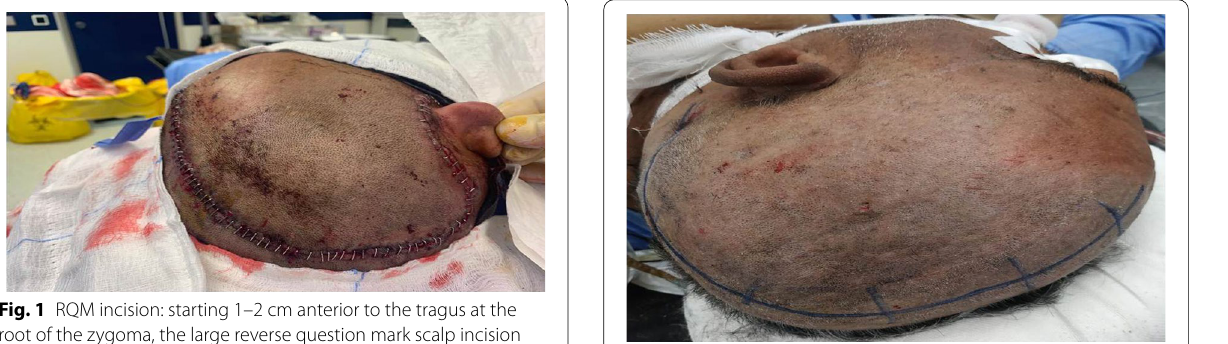
Fig. 3 The RA incision begins at the ipsilateral mastoid’s tip, softly curved superior and medial, curves posterior to the parietal eminence, eventually joins the